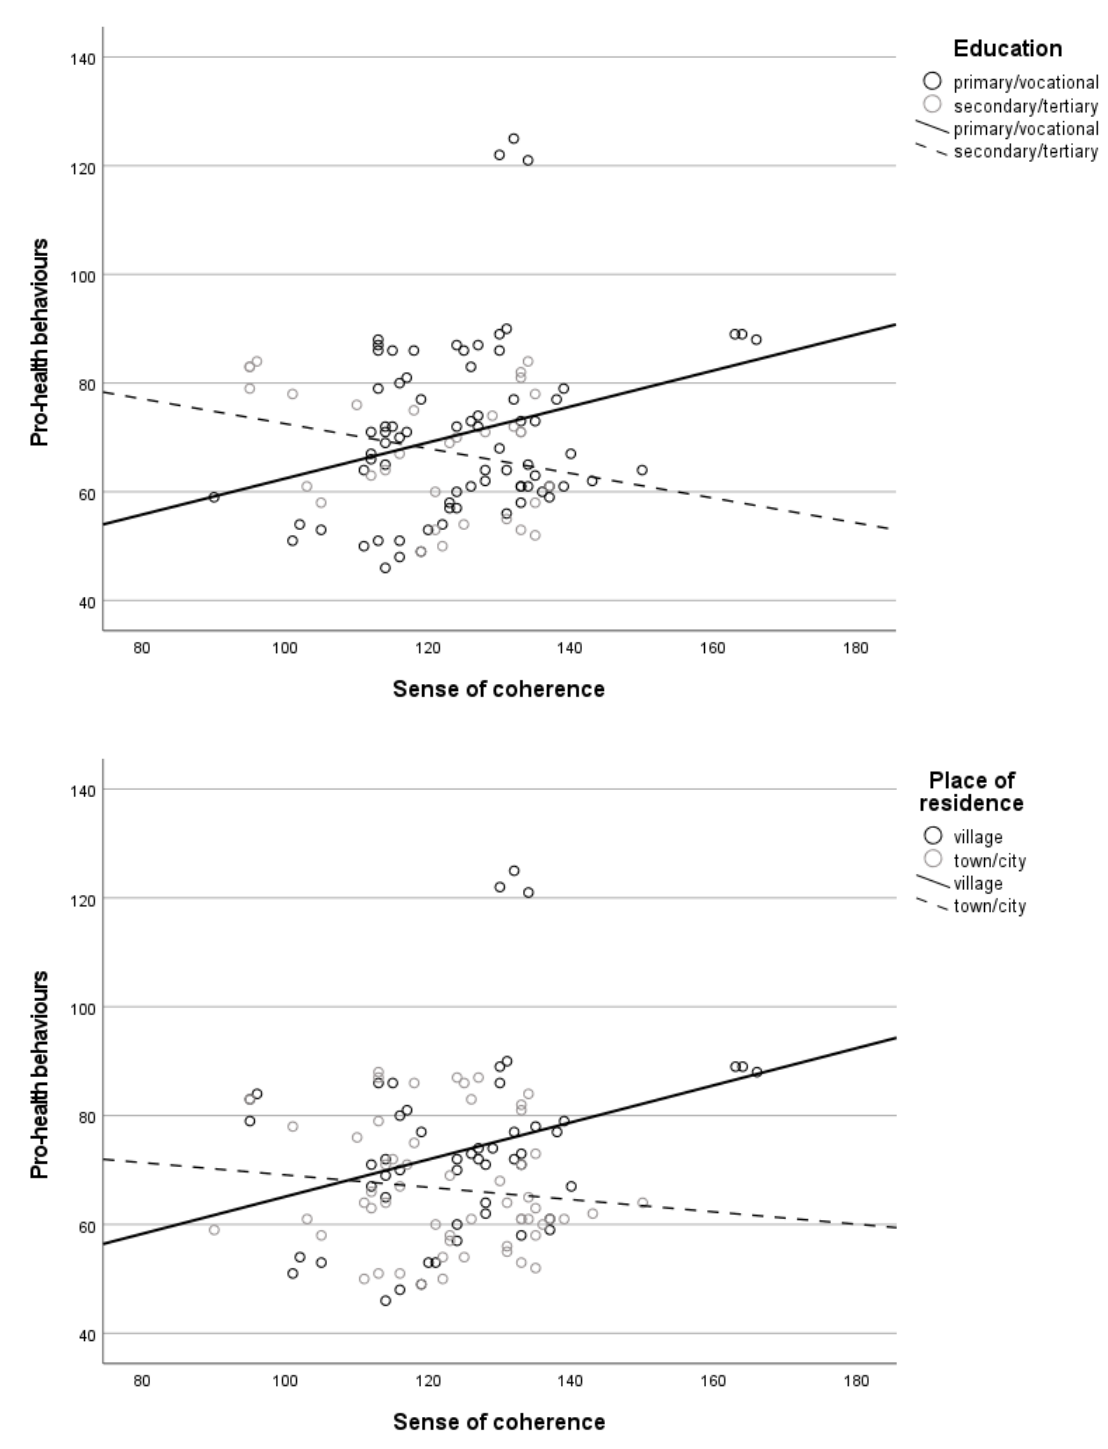
Figure 1. The correlation between SOC and the intensity of pro-health behaviors depending on the age (1), education (2), and place of residence (3) of the respondents.